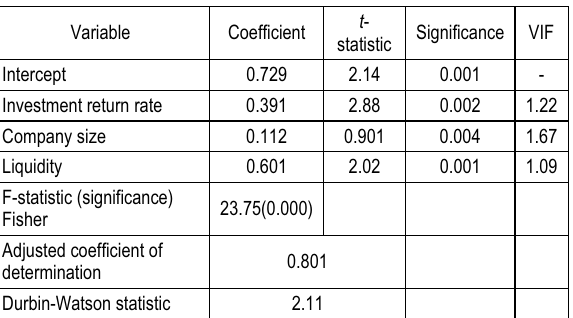
Table 4. Estimation of the model